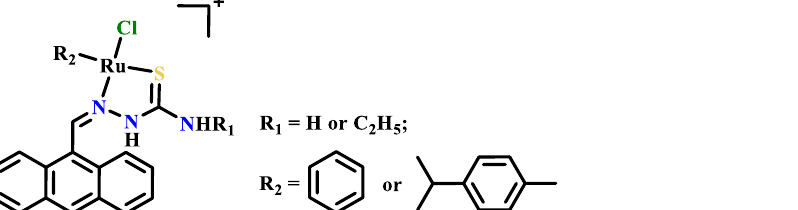
Figure 15. The organo-Ru(II) complexes of anthrahydrazone ligand with thiourea/ethylthiourea side chain.